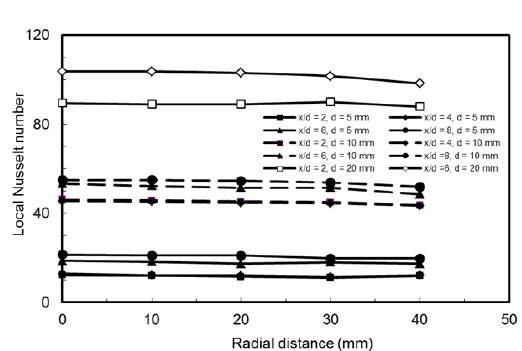
Figure 8. Radial temperature distributionon the surface of the target plate.